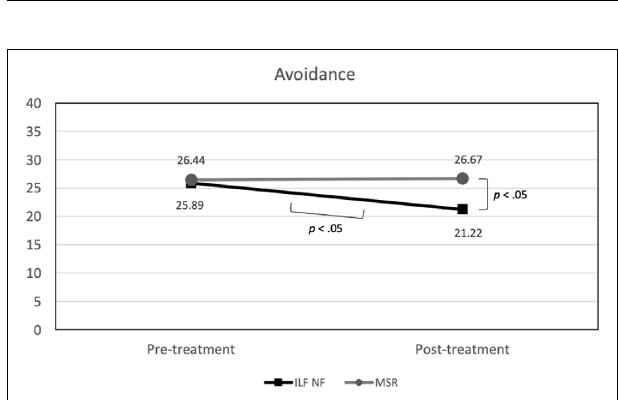
FIGURE 4 | Group × Time interaction effect on avoidance (significant mean differences are indicated).